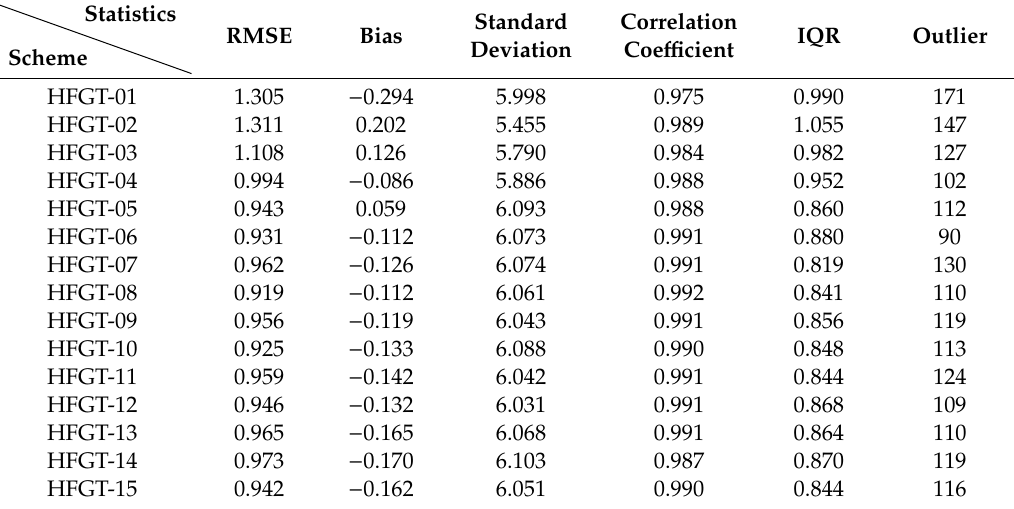
Table 1. Monthly statistics of the The High Flexibility GNSS Tomography (HFGT) results (radiosonde data (RS) from the King’s Park Meteorological Station (HKKP) was used as the reference). SchemeStatistics Standard RMSE Bias